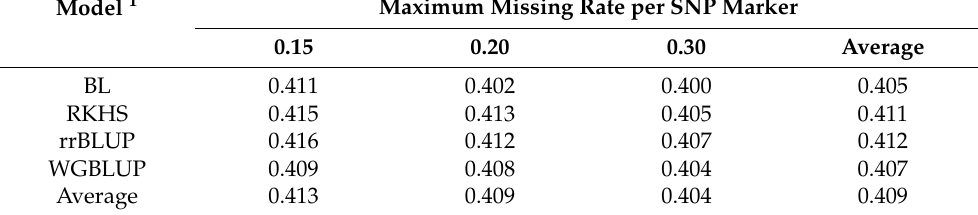
Table 5. Comparison of four statistical models for genomic selection based on their intra-environment predictive ability averaged across six traits listed in Table 4, for different thresholds of allowed missing data per SNP